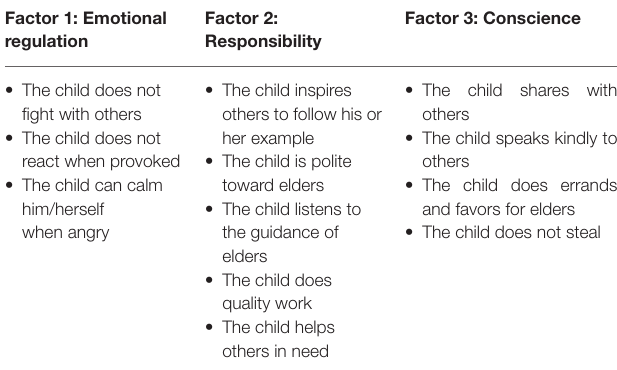
TABLE 6 | Potential caregiver SEL